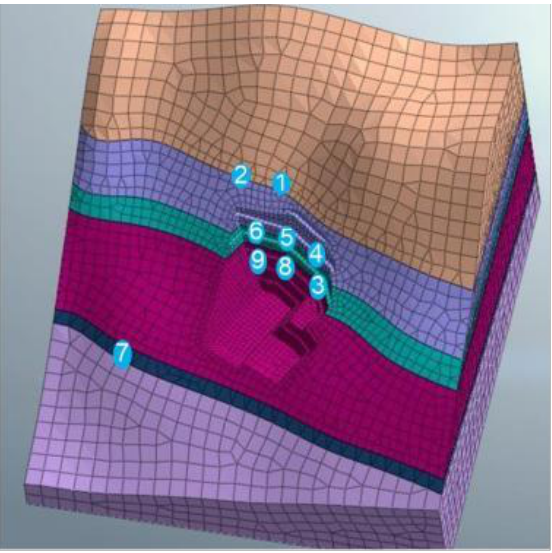
Figure 30. The monitoring point arrangement of slope deformation.